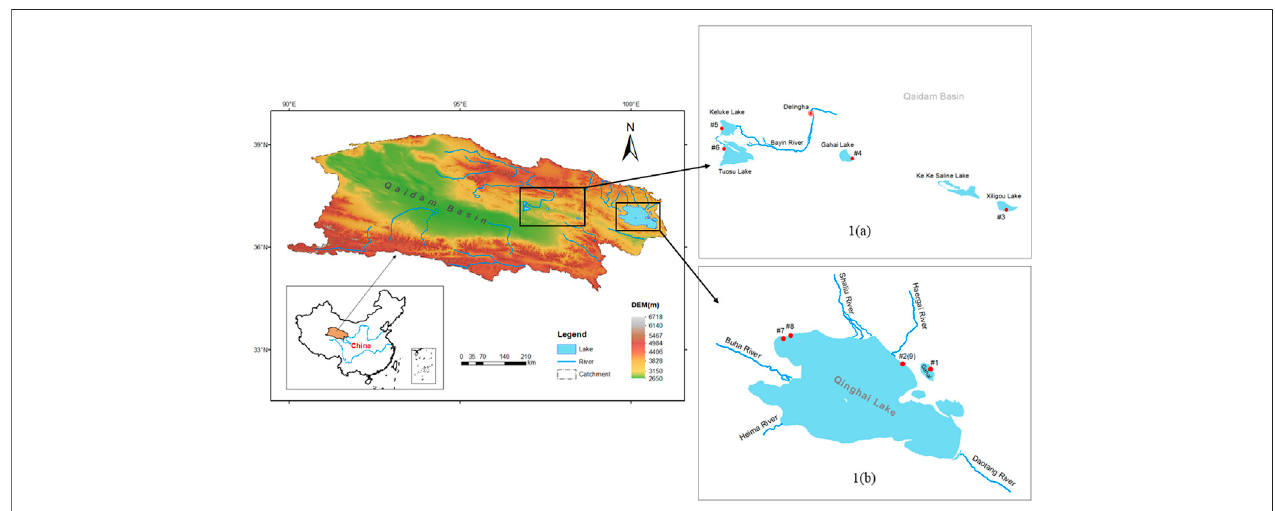
FIGURE 1 | Map showing the locations of the sampled lakes in the northeast part of the Qaidam Basin and Qinghai region.